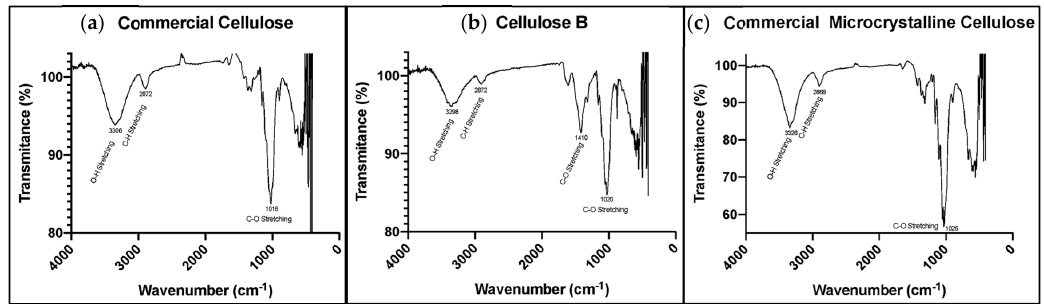
Figure 2. Fourier-transform infrared spectra of powders of the three excipients. ( a ) CC; ( b ) CMCC; ( c ) BC.